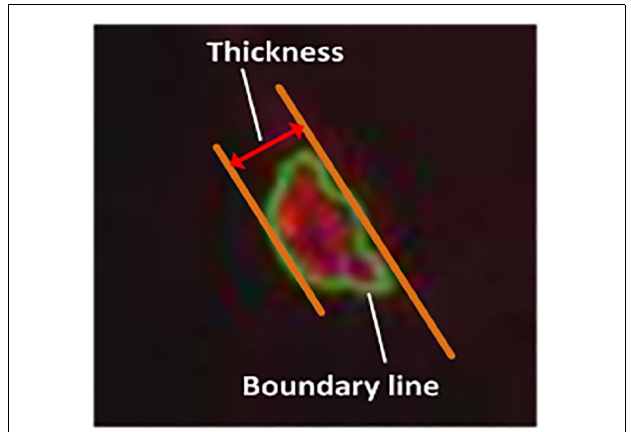
FIGURE 4 | Liquid film